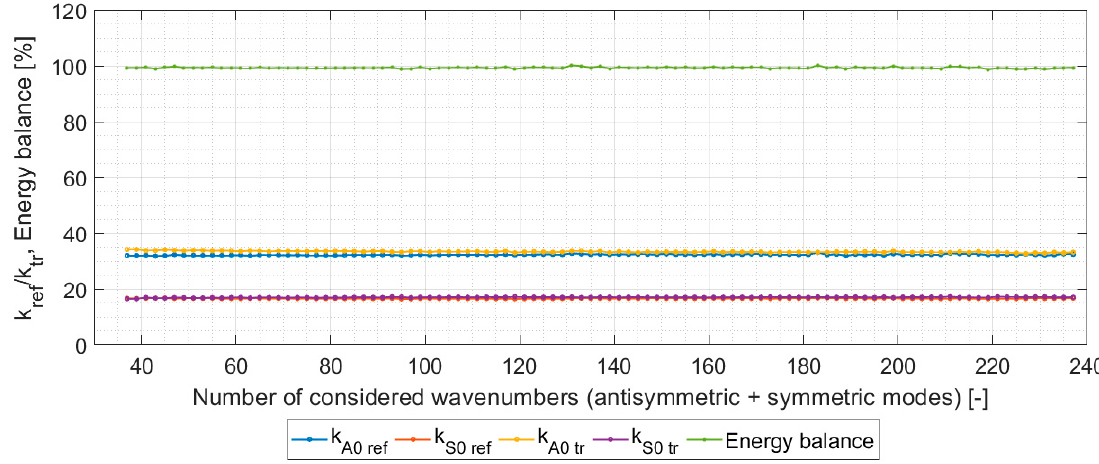
Figure 9. Numerical convergence of energy scattering coefficients in waveguide 1 (98.2% of reflected energy in sub-wave- guide 3).